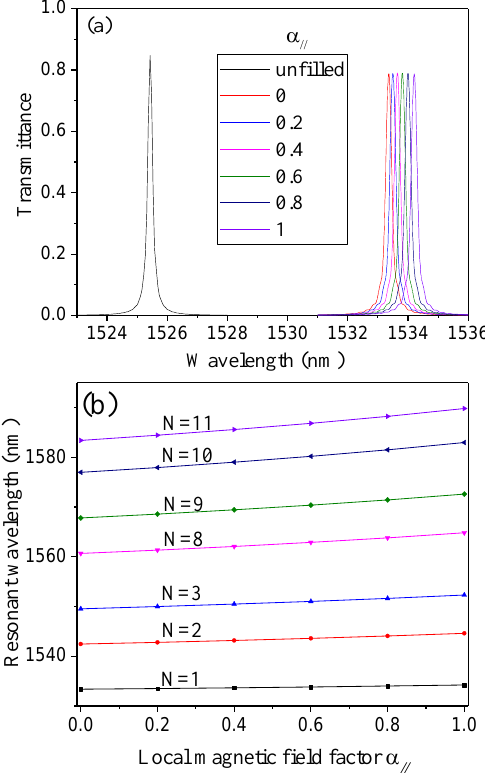
α for the center α for the center // // α for α for // //